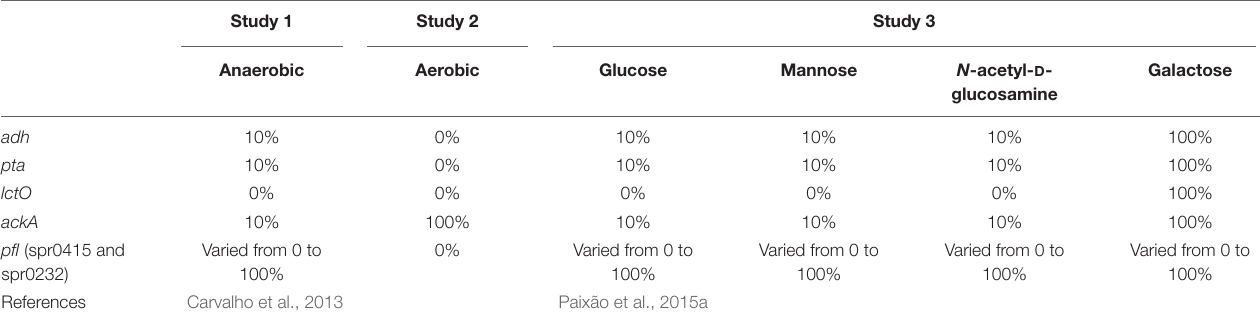
TABLE 1 | Genetic conditions used in this study.